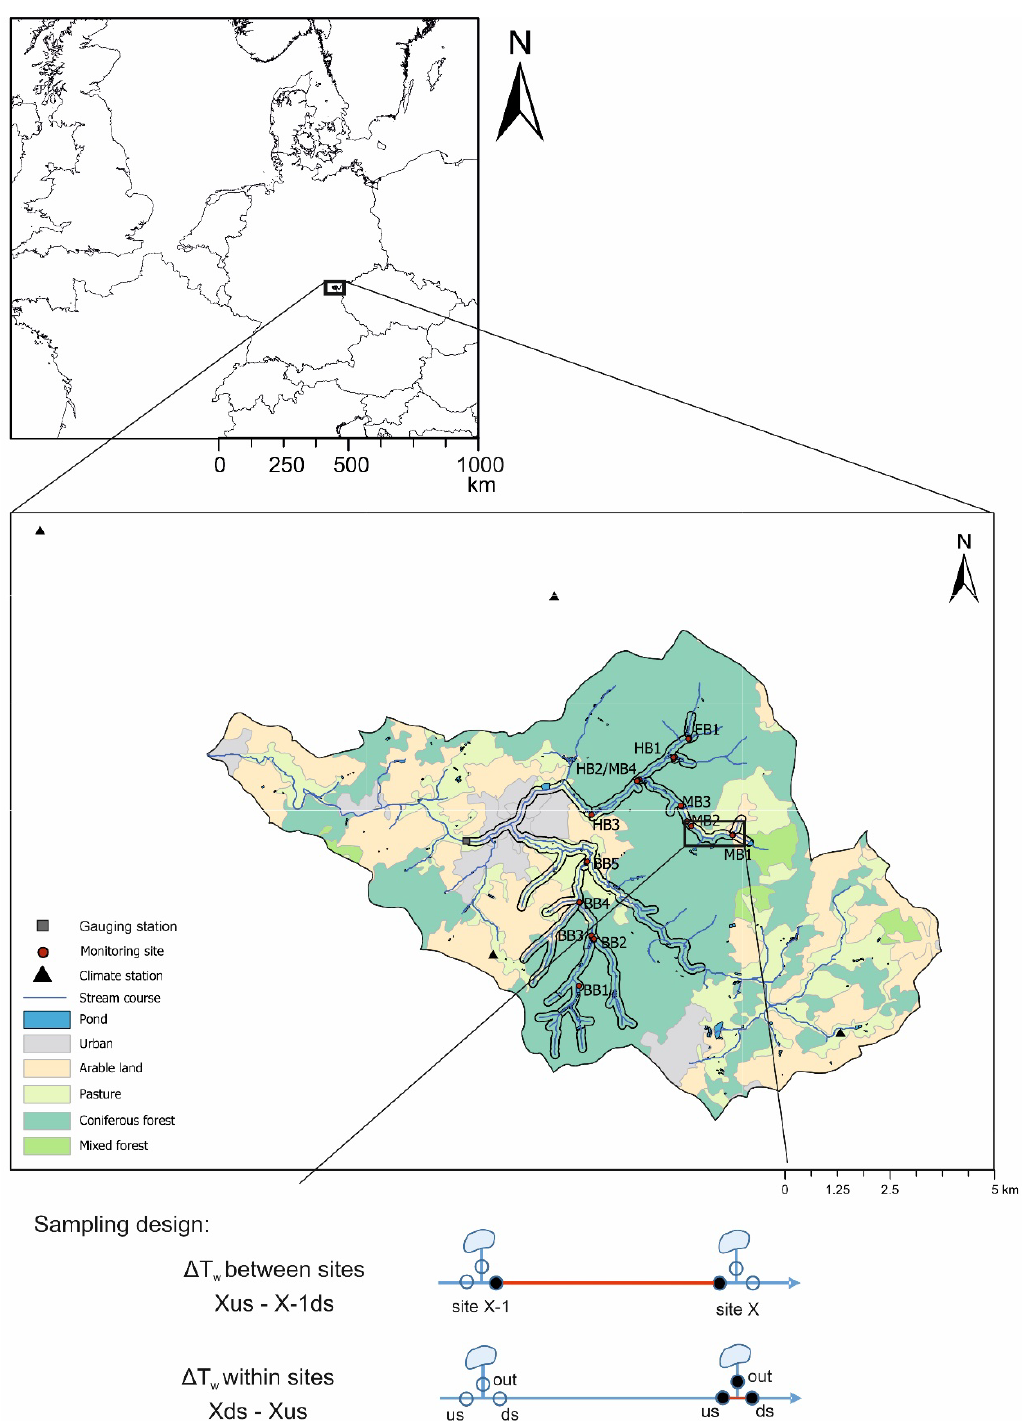
Figure 1. Map of the study catchment including stream courses as delineated in SWAT, ponds, temperature monitoring sites, climate stations, and different LU categories obtained from CORINE Land Cover Classification; the black line around the study streams represents the 180 m corridor around the streams that was used to evaluate the effect of LU on stream temperature; sampling design with the position of temperature loggers within sites and delta T w ( ∆ T w ) calculated between and within sampling sites is shown